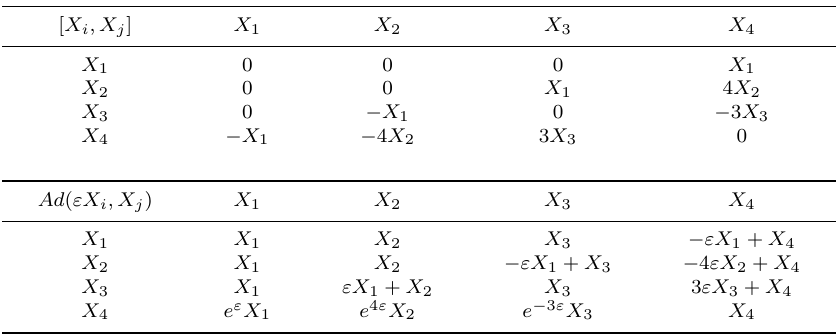
Table 1. Lie brackets and adjoints of the vector